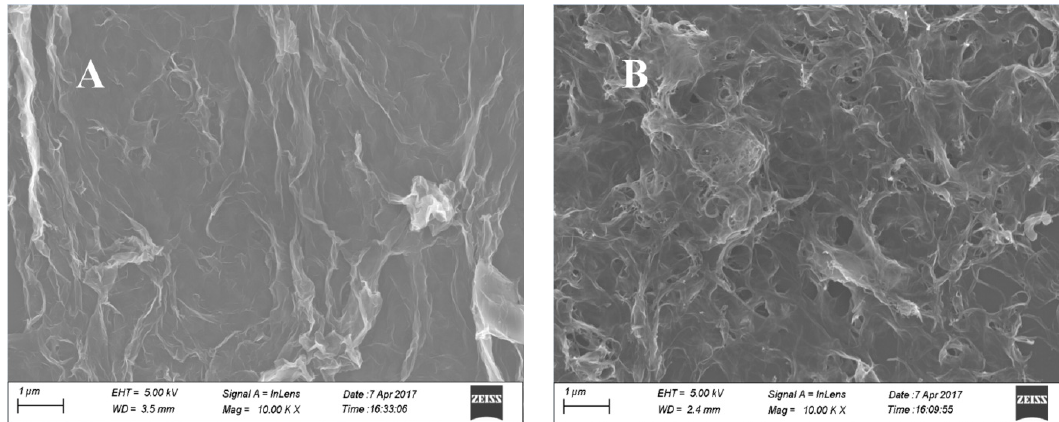
Figure 3. Scanning electron microscopy (SEM) images obtained from 3DG ( A ) and 3D graphene-nitrogen doped carbon nanotubes (3DG-NCNTs) ( B ) modified glassy carbon (GC)